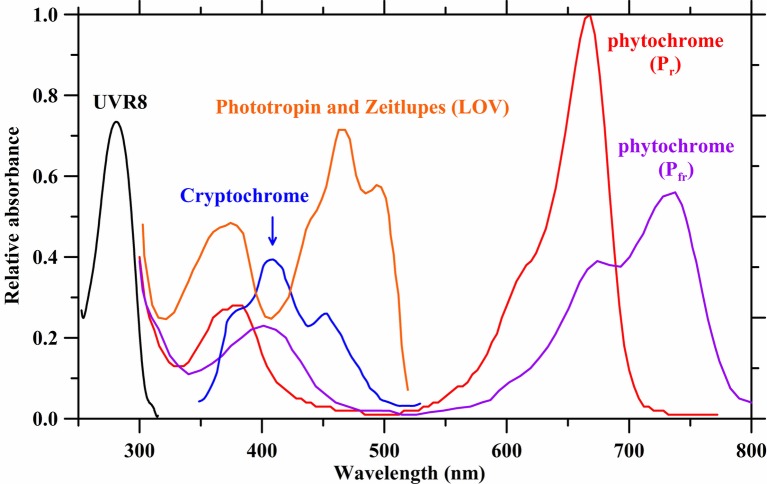
Absorbance spectra of photoreceptors. Spectrum data are derived from Taiz and Zeiger (2002), Galvão and Fankhauser (2015), and Sager et al. (1988).